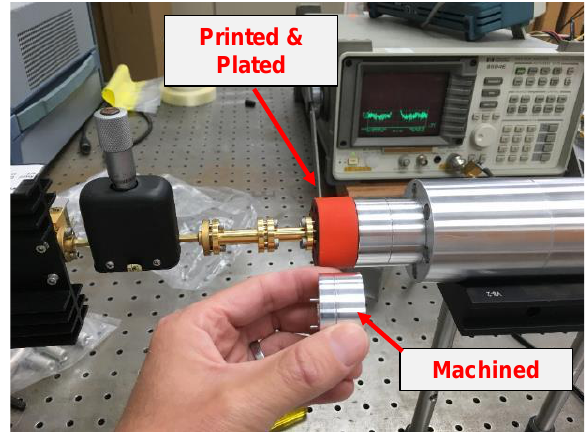
Fig. 13. Metal-plated corrugated section made via additive manufacturing used in assembly to transition from WR-6 to 63.5 mm corrugated waveguide at 140